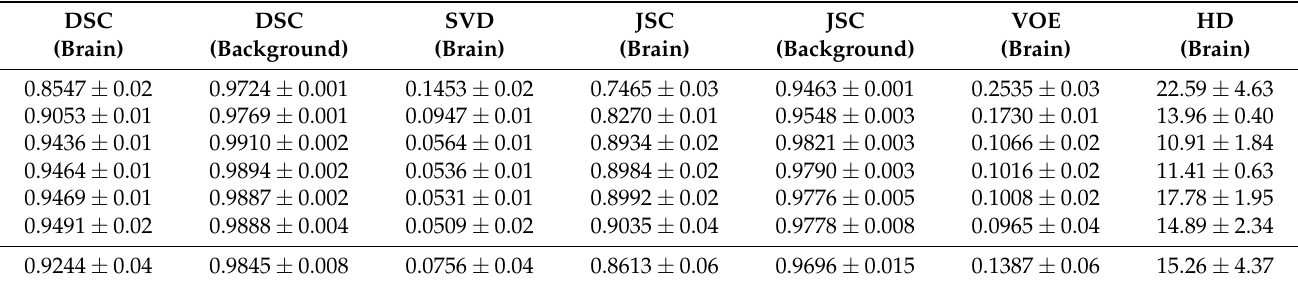
Table 4. Statistical Analysis of the brain segmentation.